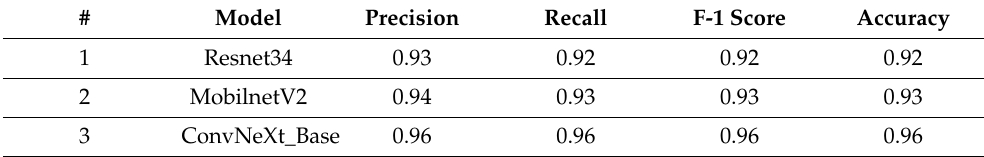
Table 3. Performance of DL algorithms for image classification